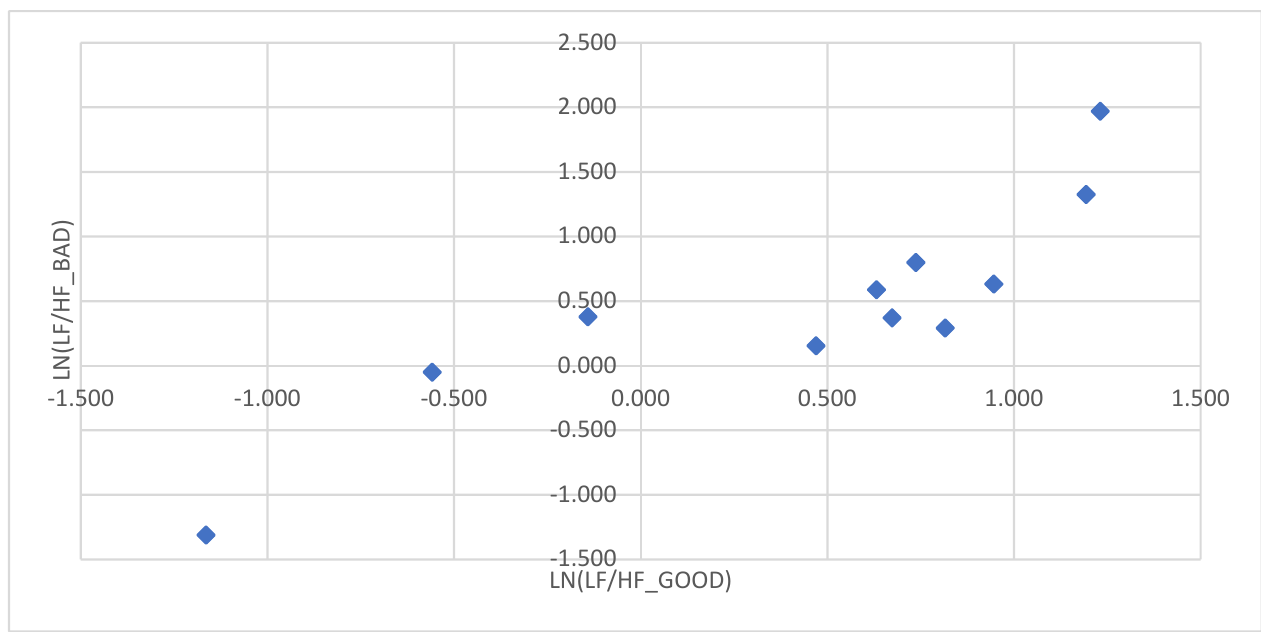
Figure 24. Percentage of responses to stimuli in volunteers when using the Dissonance complex.